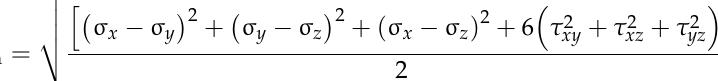
Figure 11. Bilinear stress-strain model.